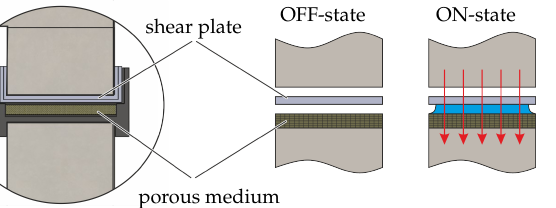
Figure 5. Working principle of the MR damper utilized in this work, with a porous medium as the fluid container.